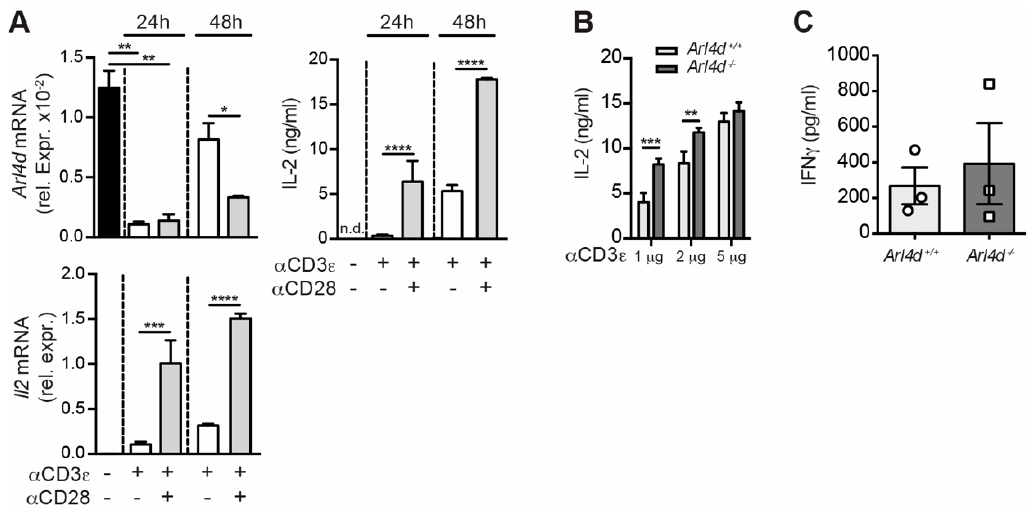
Figure 1. Regulation of Arl4d mRNA and protein in CD4 T cells. C57BL/6 splenic CD4 + T cells were stimulated with plate-bound α CD3 ε (1–2 μ g/mL) with ( A ) or without ( A – C ) soluble α CD28 antibodies (5 µ g/mL) for the indicated times, after which ( A ) cells were harvested for RNA isolation and qPCR analysis of Arl4d mRNA and ( B , C ) supernatants were analyzed for their IL-2 or IFN γ contents by ELISA. ( A , B ) Representative of two independent experiments. ( C ) Cumulative data from three independent experiments. Statistical significance was calculated using ANOVA. * p ≤ 0.05, ** p ≤ 0.01, *** p ≤ 0.001, **** p ≤ 0.0001. n.d.: not detectable.